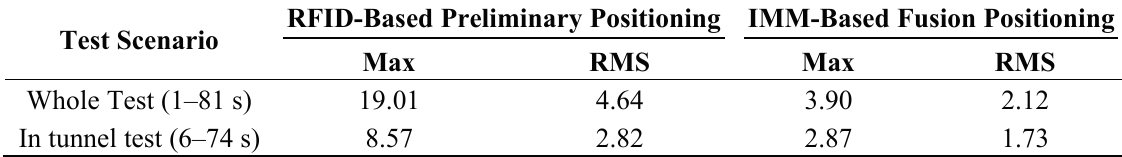
Table 4. Statistics of the Euclidean distance errors in different tests (unit: